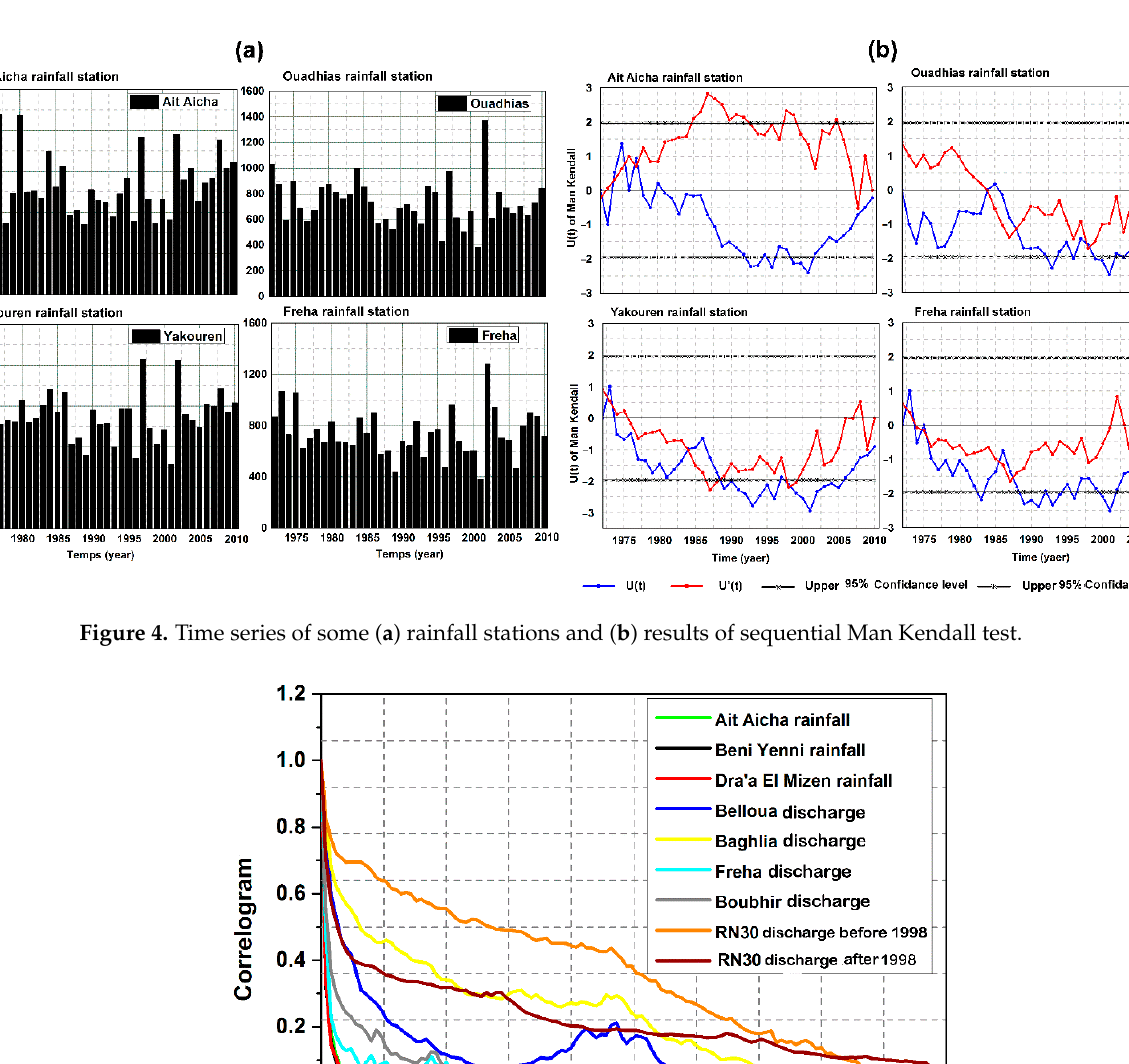
Figure 5. Correlogram of daily rainfall and runoff time series (windows of 125 days). Table 2. Classification of six karstic systems of Sebaou River basin and some representative Mediterranean karstic system based on CSA of daily